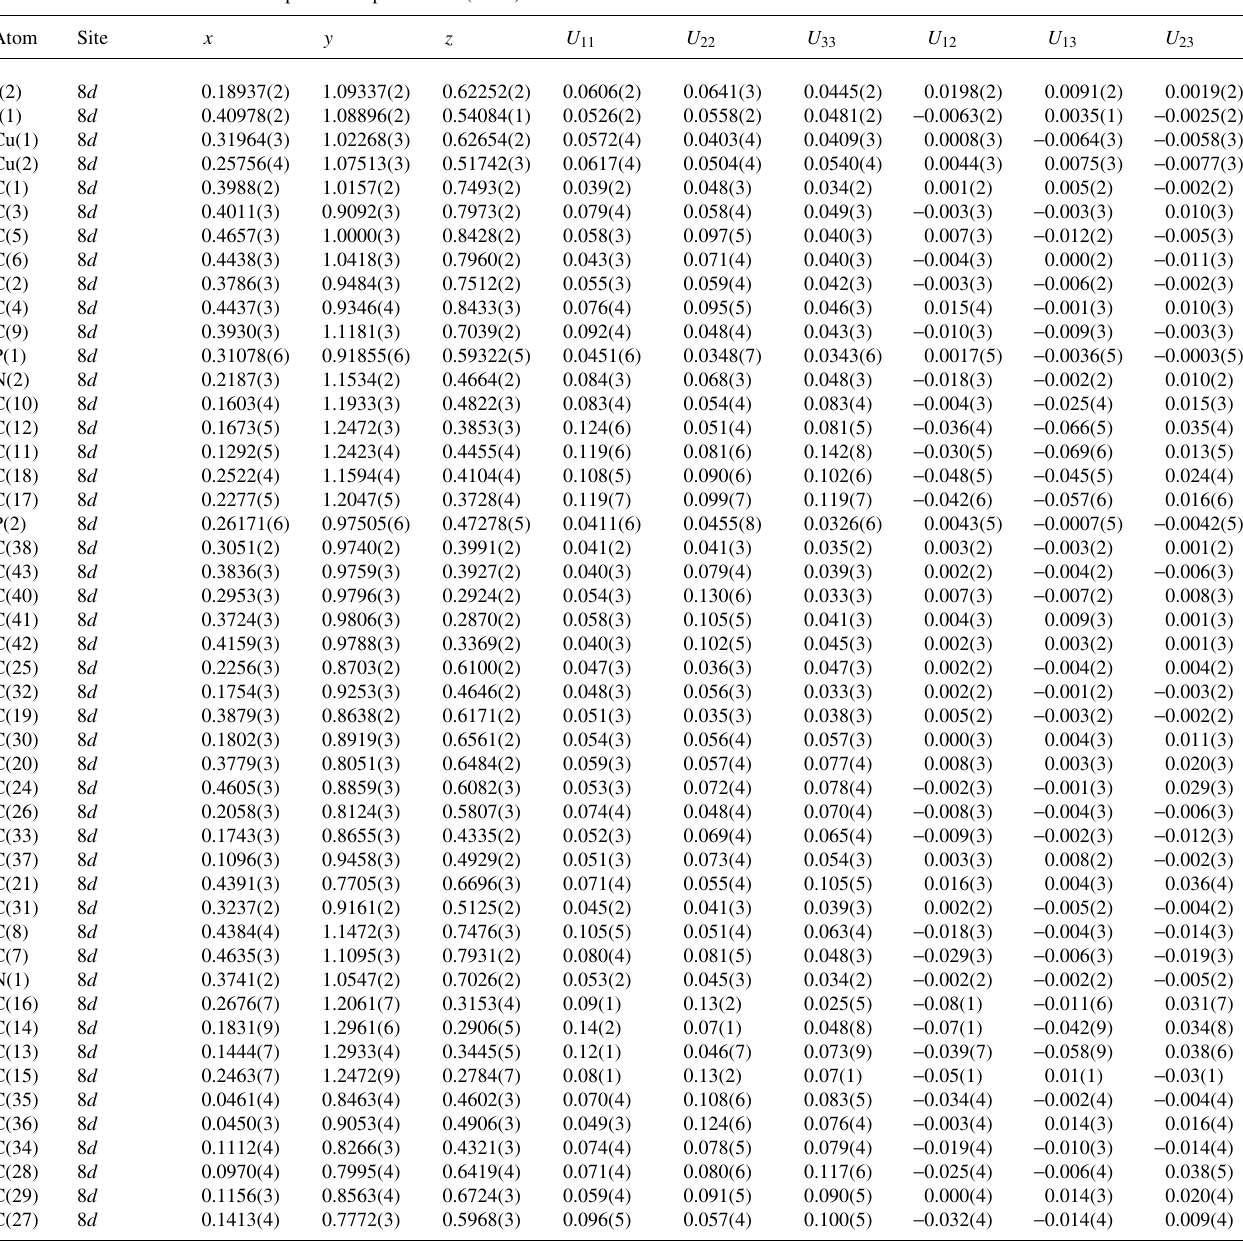
Table 3. Atomic coordinates and displacement parameters (in Å 2 )